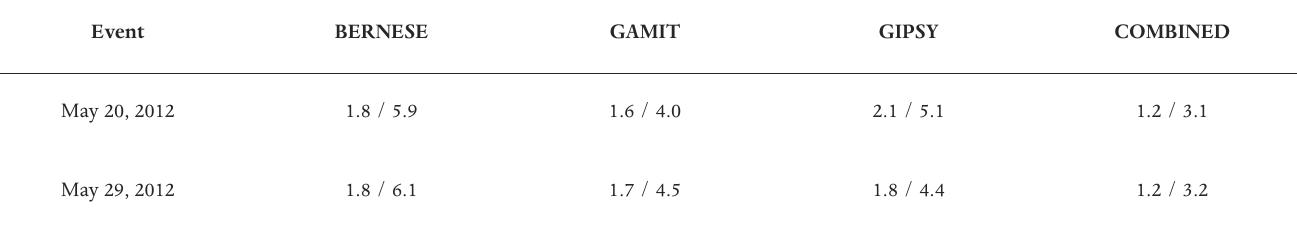
Table 1. Average formal errors (1-sigma) of the estimated coseismic offsets. The two values represent the horizontal and vertical components, respectively, of the